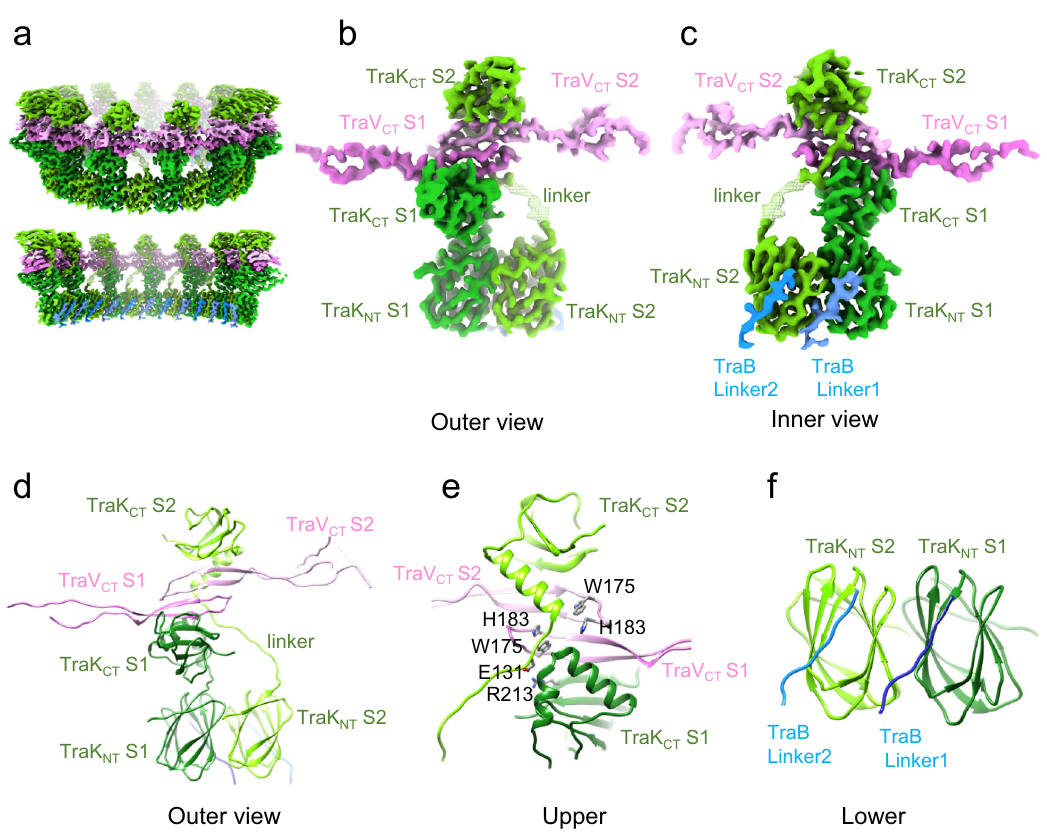
Fig. 2 Structure of the outer ring complex (ORC). a Overview (upper) and a central cut view (bottom) of the 3.31 Å ORC from the pED208-carrying (WT) strain reconstructed with 13-fold symmetry imposed. b , c Outer and inner views of the heterodimer structural unit including two TraK monomers and two C-terminal domains of TraV (TraV CT ). Different subunits are denoted S1 and S2. The two N-terminal domains of TraK (TraK NT ) are arranged side-by-side, and the two C-terminal domains (TraK CT ) are fl ipped 180° relative to each other. The two TraV CT domains pack antiparallel to each other. A fl exible linker connecting the TraK NT -S2 and TraK CT -S2 domains is visible as a blurred density at low (10 Å) resolution. Two TraB linker segments corresponding to residues R176-186 form speci fi c contacts with TraK NT domains. d , e , f Atomic models of the ( d ) entire structural unit, ( e ) the upper TraK CT /TraV CT complex showing residues whose interactions are predicted to stabilize the ORC, and ( f ) the lower TraK NT dimer with associated TraB linker segments. Colors for all panels: TraK-S1 and TraV-S2(dark and light green), TraV-S1 and TraV-S2 (dark and light pink), TraB R176-S186 linkers